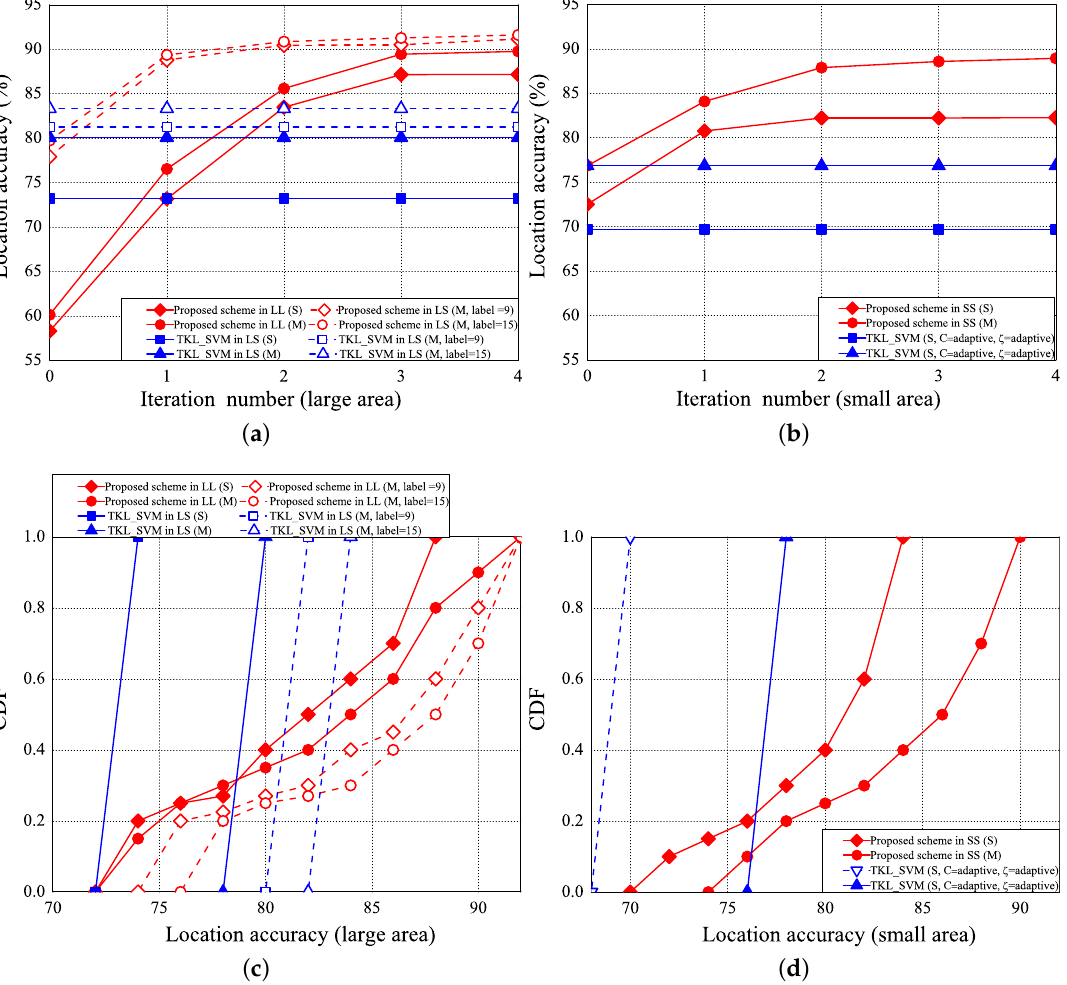
Figure 15. ( a ) Location accuracy vs. number of iterations (LL,LS); ( b ) location accuracy vs. number of iterations (SS); ( c ) CDF vs. location accuracy (LL,LS); ( d ) CDF vs. location accuracy